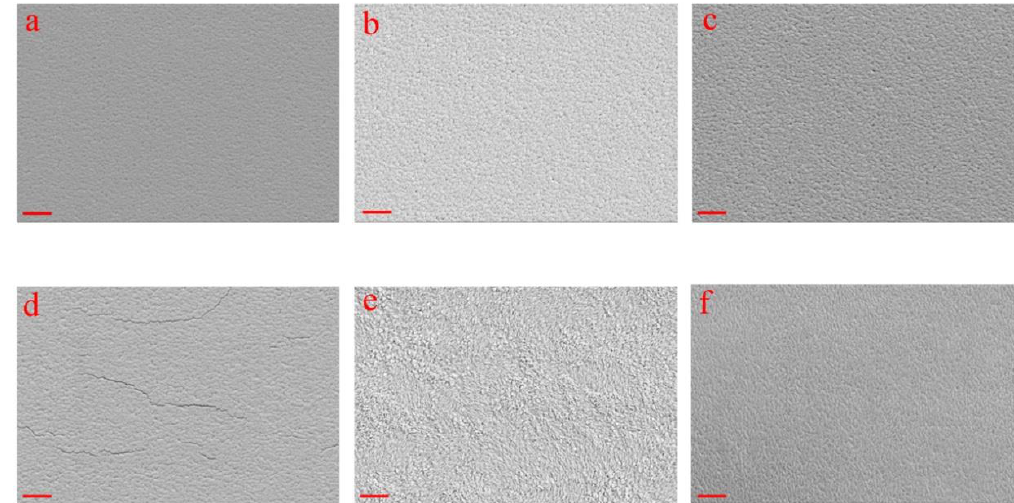
Figure 1. Scanning electron microscope (SEM) top-view images of as-deposited Sb 2 Se 3 thin films sputtered under 2.0 Pa ( a ), 1.5 Pa ( b ), 1.0 Pa ( c ), 0.5 Pa ( d ), 0.1 Pa ( e ), and mixed pressures ( f ). The red scale bar at the left bottom corner of each figure reads 1 µm.